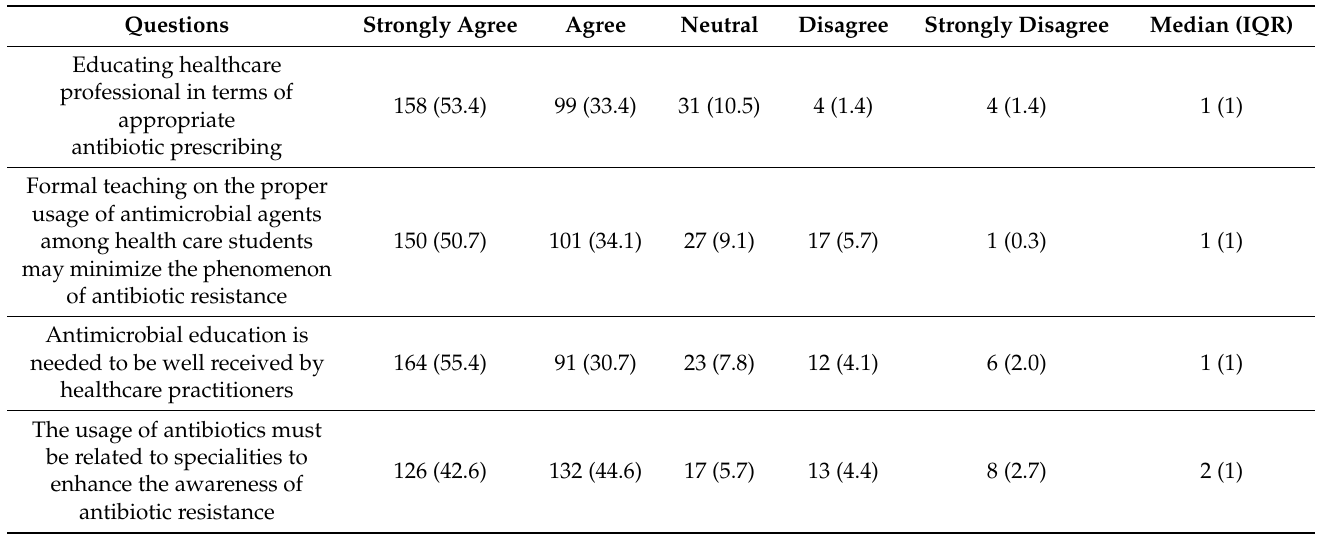
Table 6. Attitude towards minimizing antibiotic resistance n